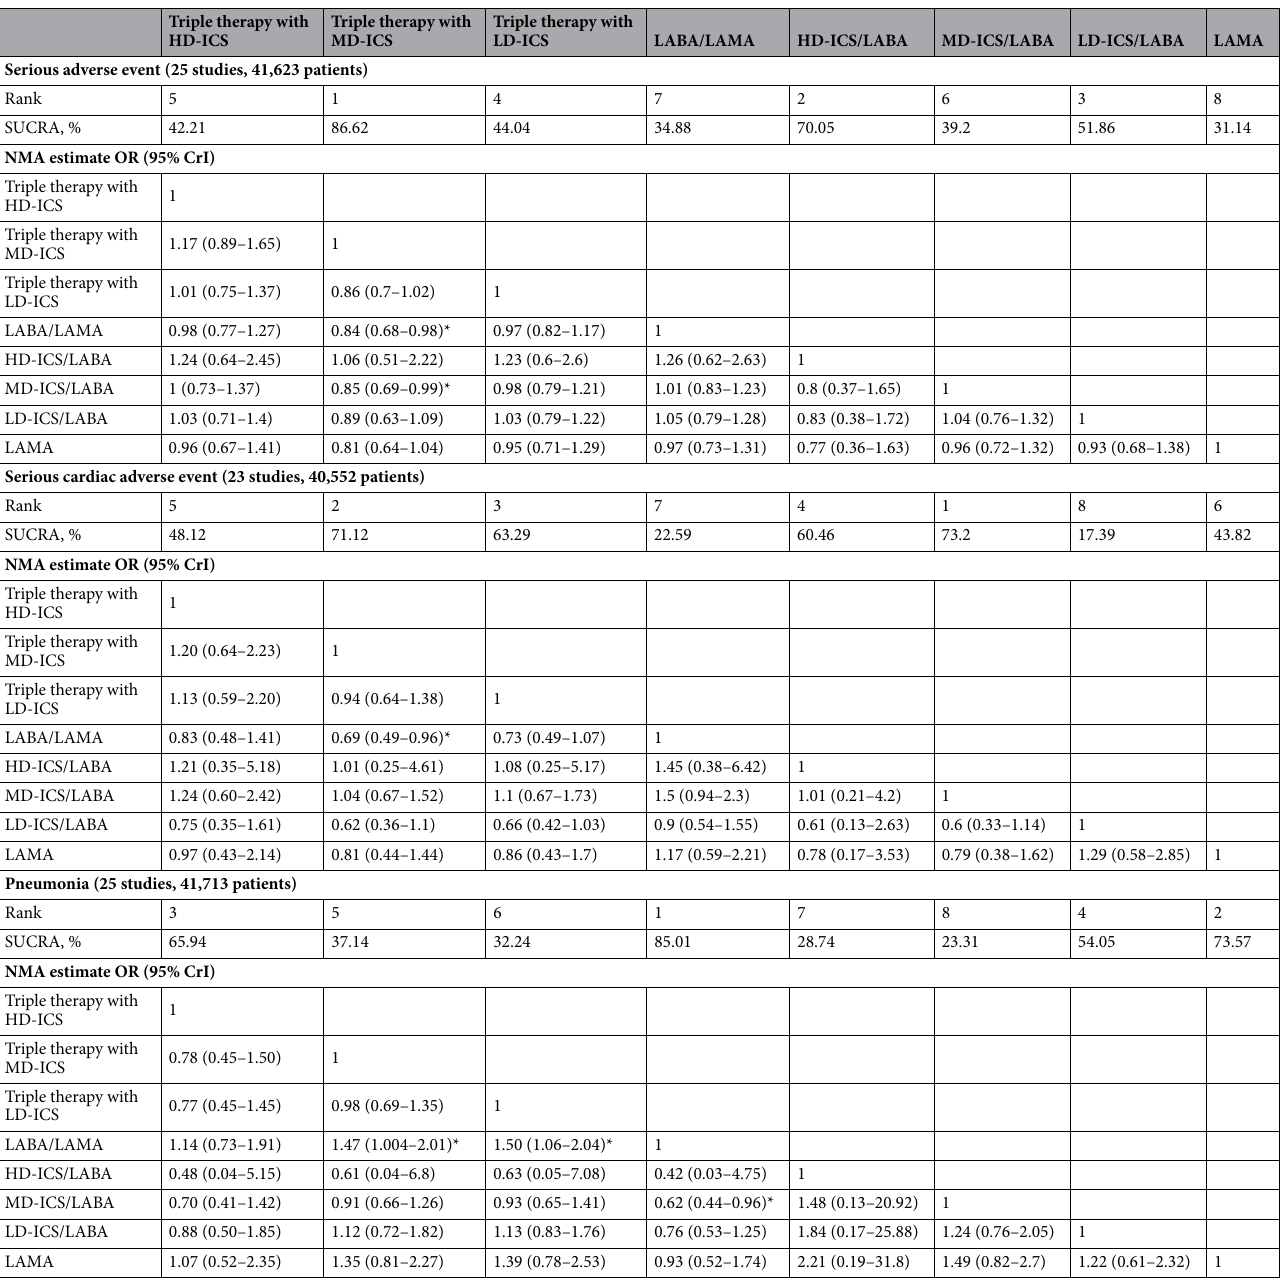
Table 4. Adverse events associated with different inhaled therapies. CrI: credible interval; HD: high-dose; ICS: inhaled corticosteroid; LABA: long-acting beta-agonist; LAMA: long-acting muscarinic antagonist; LD: low-dose; MD: medium-dose; NMA: network meta-analysis; OR: odds ratio; SUCRA: surface under the cumulative ranking curve. Median OR with 95% CrI was calculated as a row to column ratio. If the OR is significantly lower than 1, the drug in the left row is considered to be more beneficial than the other drug in the upper column. *Indicates that the posterior probability is either less than 0.025 or more than 0.975, which is considered statistically